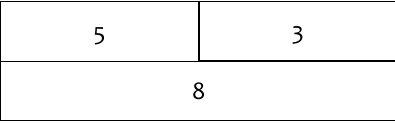
Figure 2: The diagram showing Sam’s answer to eight counters, five